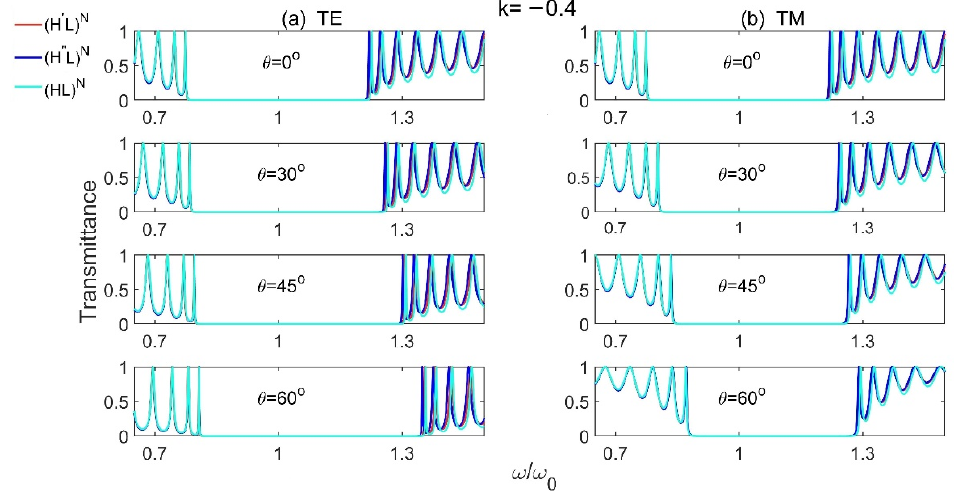
Figure 6. The transmission spectra of Model 3 (𝐻𝐿 (cid:4593) ) (cid:3015) , Model 4 (𝐻𝐿 (cid:4593)(cid:4593) ) (cid:3015) and the reference model (𝐻𝐿) (cid:3015) for different incident angles at slope 𝑘 = −0.4 of the gradient materials for ( a ) TE and ( b ) TM polarizations.